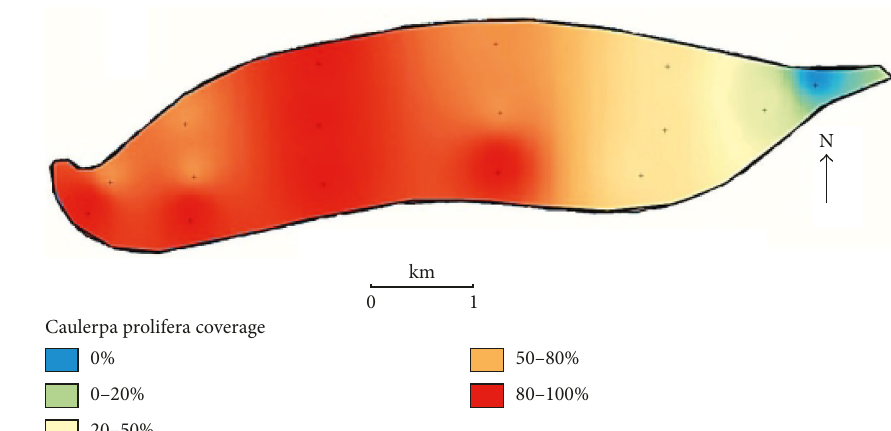
Figure 6: The distribution of Caulerpa prolifera in the South Lagoon of Tunis in summer 2014